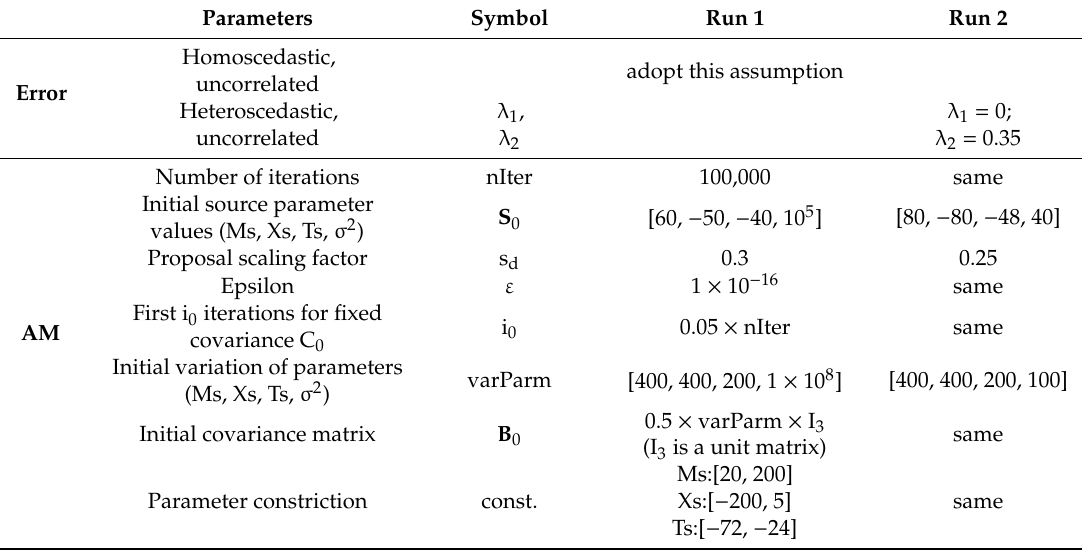
Table 2. The Adaptive Metropolis (AM) algorithm parameter